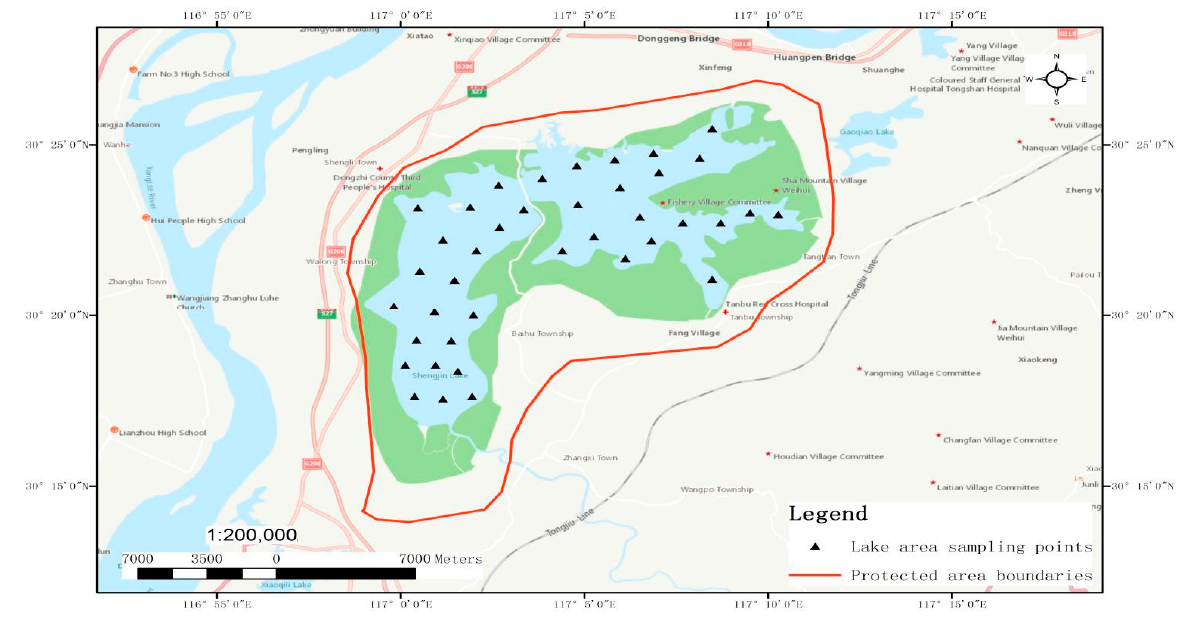
Figure 1. Distribution of field survey sites in Shengjin